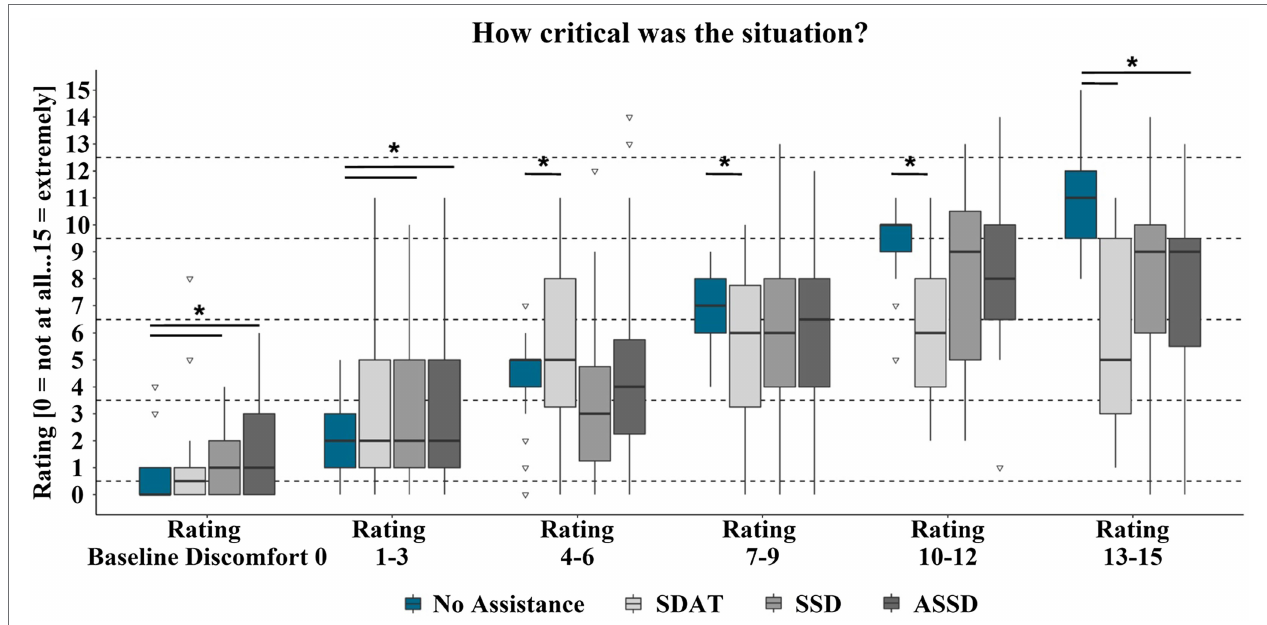
FIGURE 7 | Criticality ratings for rides with and without assistance by discomfort ratings in the baseline ride. Significant ( p < 0.05) differences between ratings with and without assistance system are marked with * . Box range = Q1 to Q3. Whiskers = 1.5